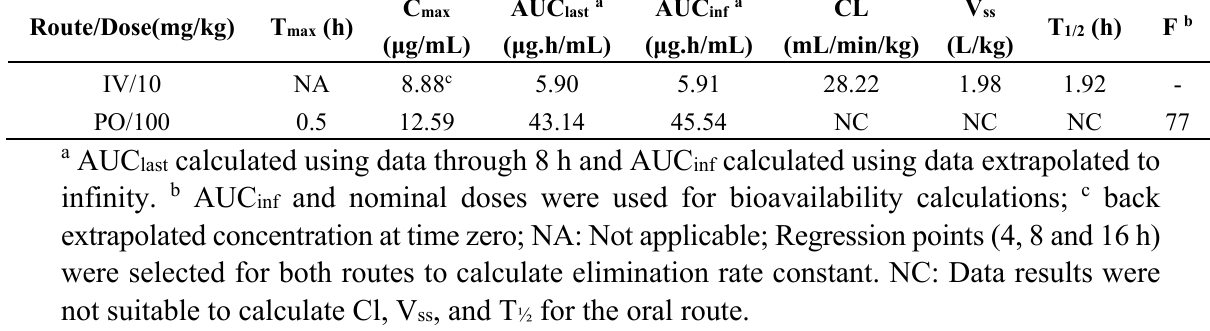
Table 3. Mean pharmacokinetic parameters of UV-12 in male Swiss Albino mice. Route/Dose(mg/kg)